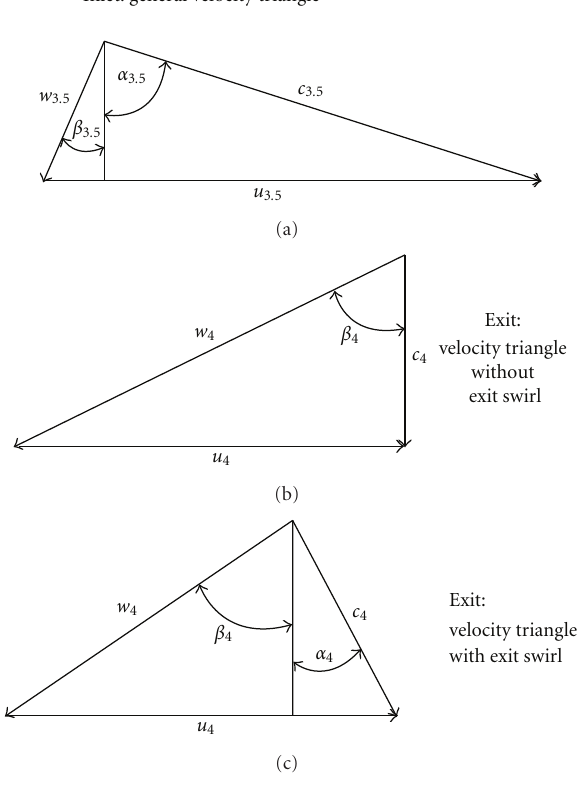
Figure 4: Velocity triangles at turbine wheel inlet and